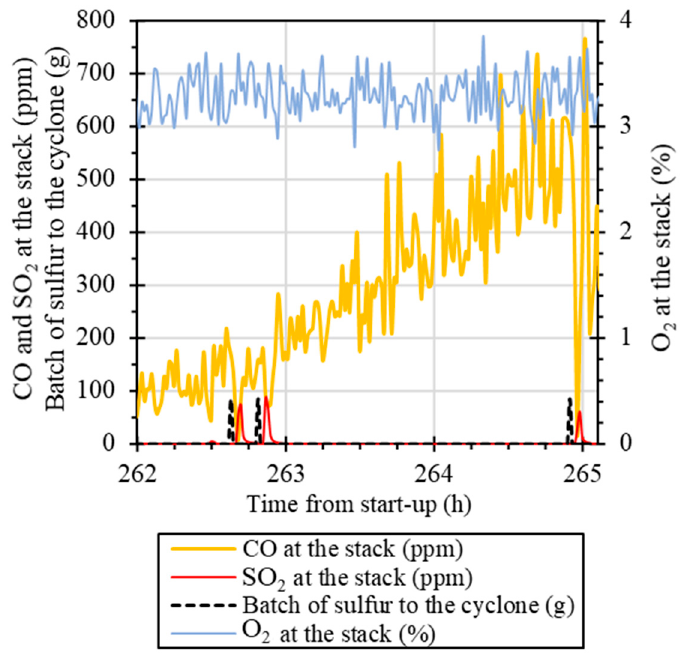
Figure 10. CO and SO 2 concentrations in the flue gases at the stack and the effects of addition of three batches of 85 g of elemental sulfur to the flue gas exiting the